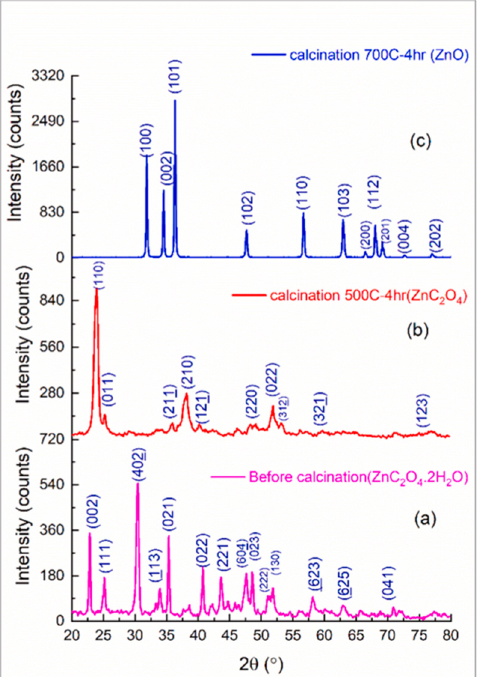
Figure 5. XRD analysis before calcination ( a ), after calcination at 500 °C ( b ), and after calcination at 700 °C ( c ) [36]. Reprinted from an open-access source.